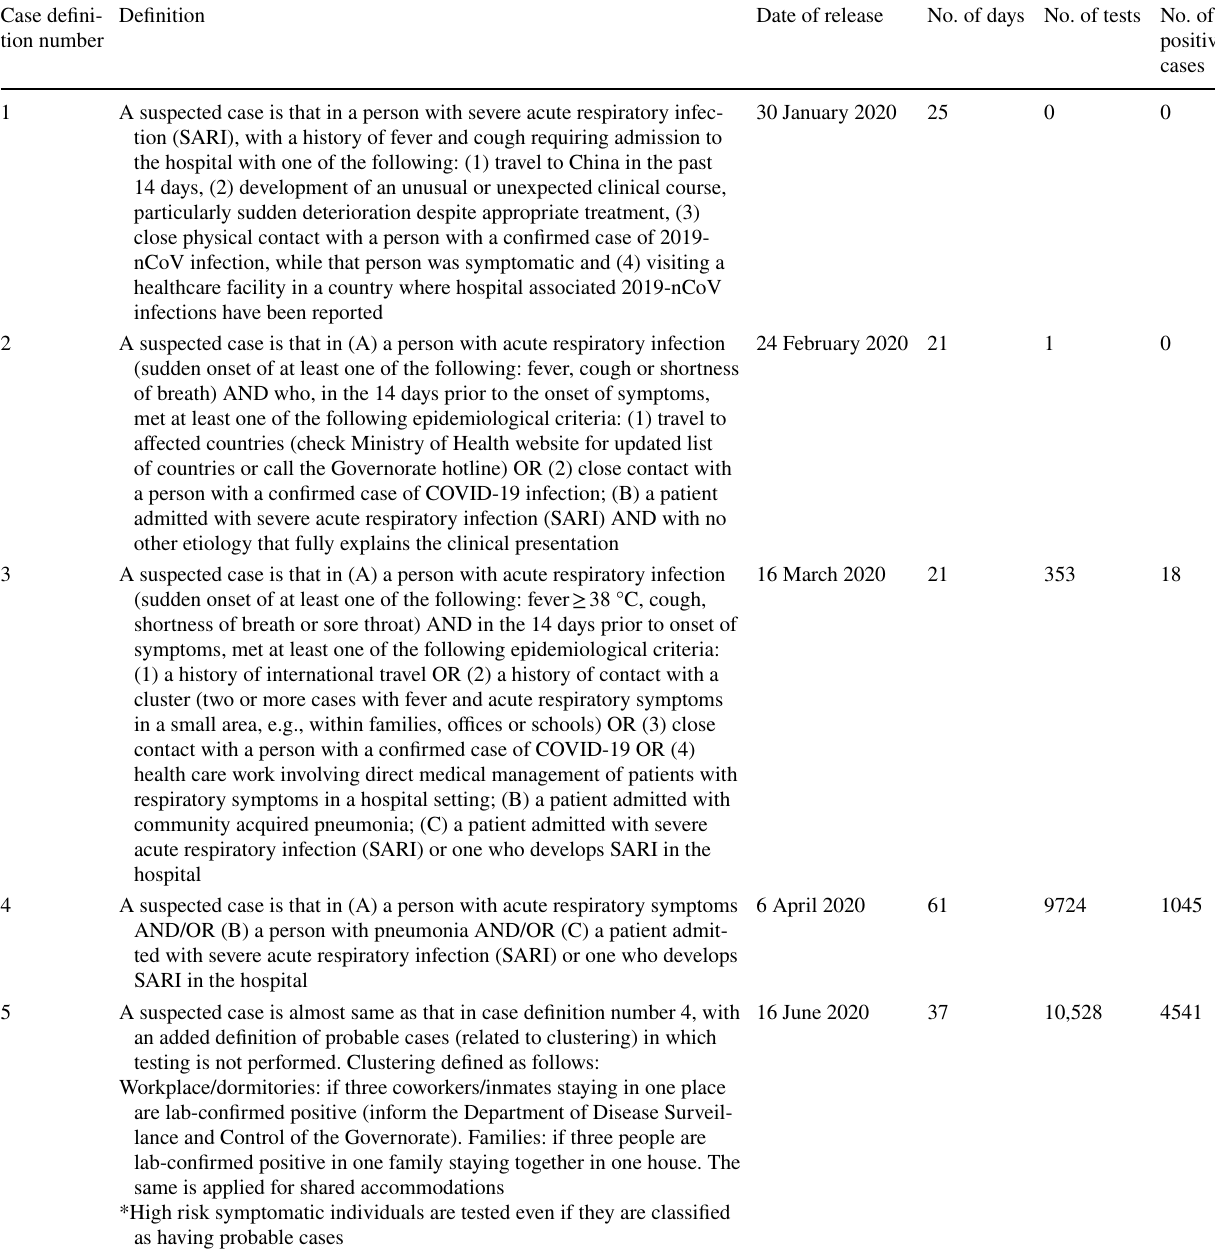
Table 1 Timeframe for the five definitions of suspected cases and the corresponding number of tests and positive cases Case defini- tion number